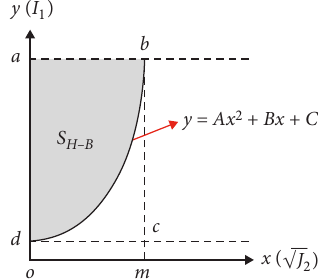
Figure 7: H–B standard area